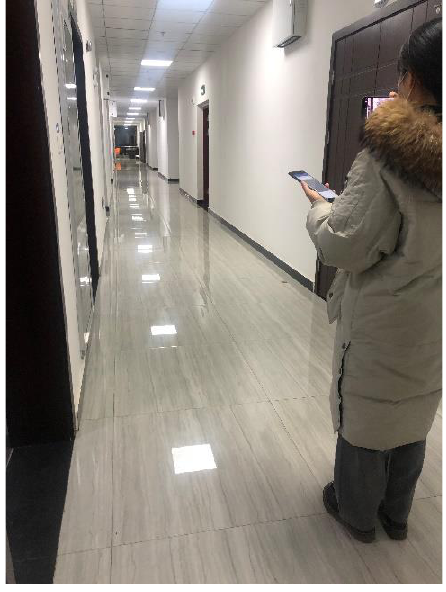
Figure 6 . Experiment